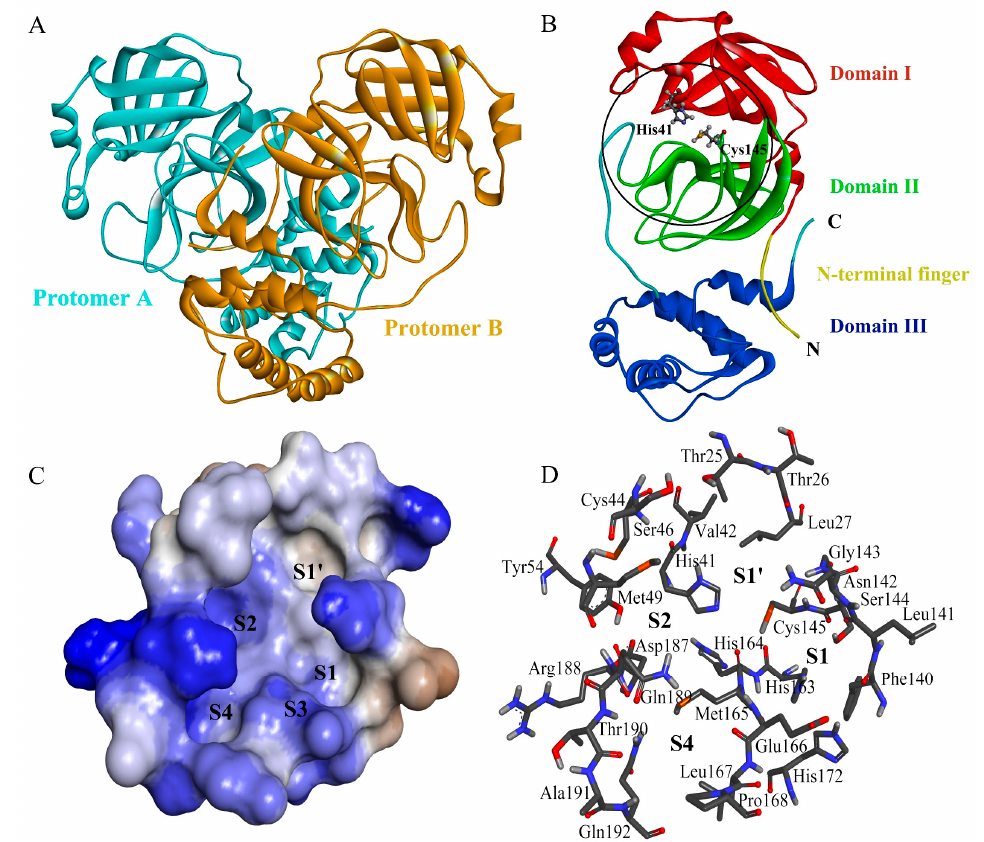
Figure 1. Three-dimensional structure of the SARS-CoV-2 Mpro and its substrate-binding sub- site/pockets. ( A ) Cartoon representation of the crystal structure of the Mpro dimer (PDB ID: 7ALI [30] ). The two protomers/monomers are colored cyan and bronze, respectively; ( B ) cartoon repre- sentation of the crystal structure of an Mpro protomer (PDB ID: 7L0D [34] ). The N-terminal finger and domains I–III are colored differently. The catalytic dyad residues, Cys145 and His41, are shown in ball-and-stick representation; ( C ) surface representation of Mpro showing the sub- strate-binding pockets/subsites S4, S3, S2, S1, and S1 ′ . The protein surface is colored by hydropho- bicity, with the color gradient ranging from blue for the most hydrophilic surface to brown for the most hydrophobic surface; ( D ) amino acid residues that form the substrate-binding pockets S4, S2, S1, and S1 ′ . Residues are shown in stick representation, with C, O, N, S, and H atoms colored in gray, red, blue, orange, and white, respectively.